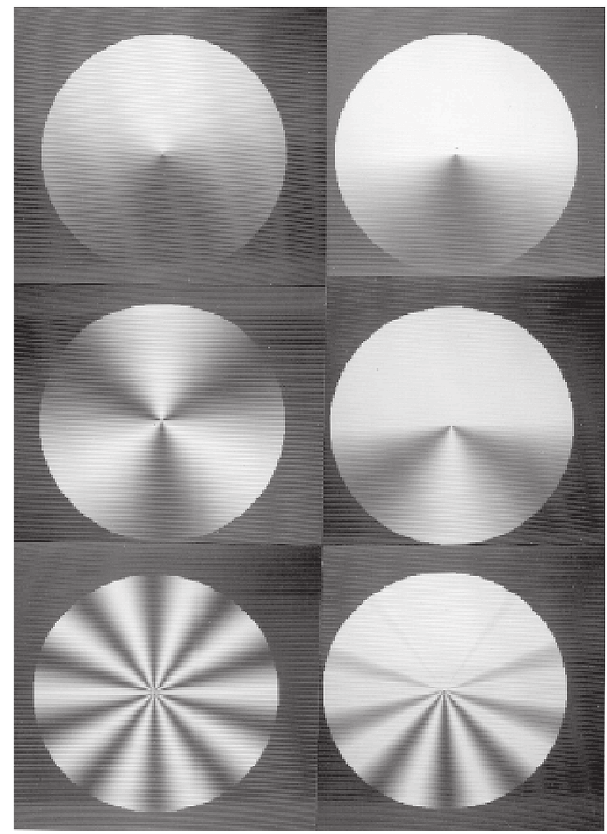
Figura 1. Exemplos de pares de estímulos de freqüências angulares utilizados para estimar o filtro angular de 1 ciclo/360º. Na coluna da esquerda, de cima para baixo, as freqüências de fundo de 1, 3 e 10 ciclos/360º e na coluna da direta, as freqüências da